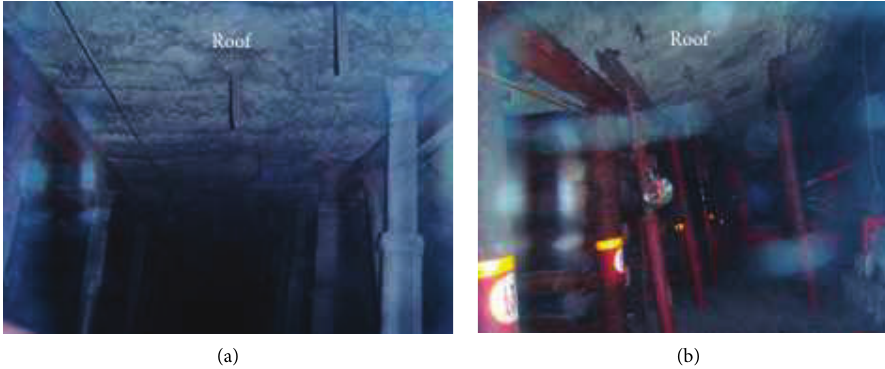
Figure 13: Roof form of the gob-side entry retaining in the reuse period. (a) Roof form in section 1; (b) roof form in section